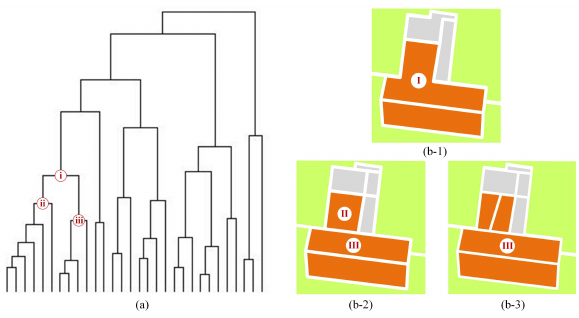
Figure 2. The hierarchical segmentation tree and the corresponding